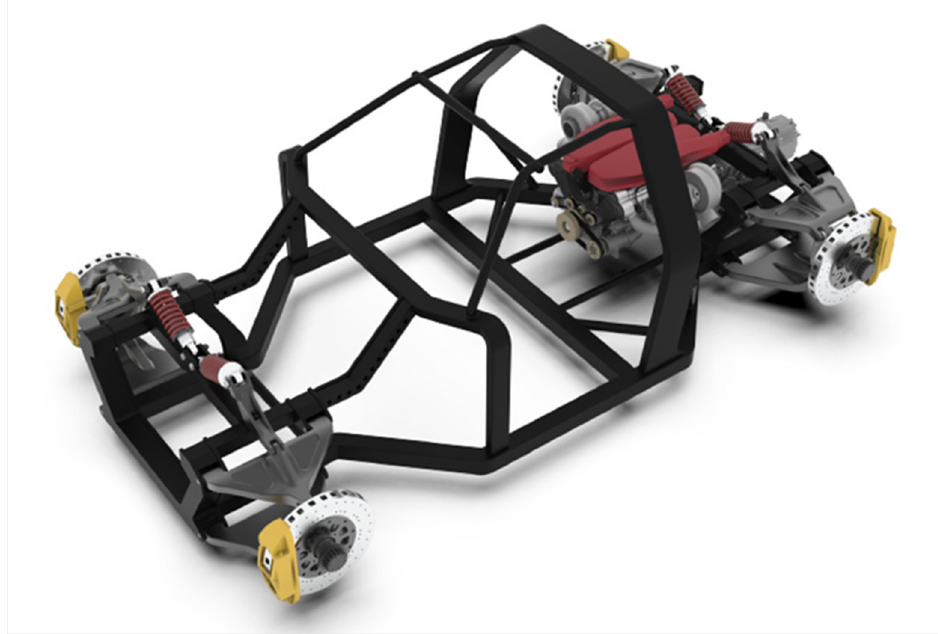
Figure 27. Rendered Chassis assembly.